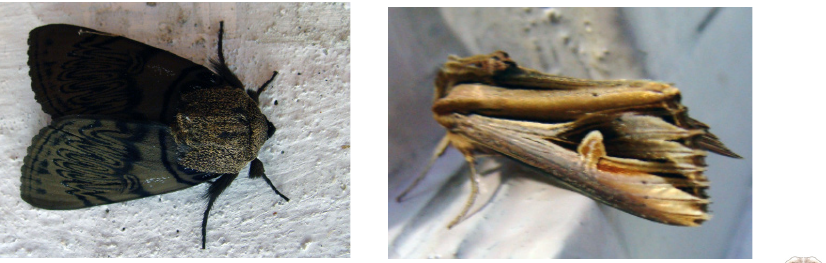
Image 24. Arcte polygrapha Kollar (Erebidae)